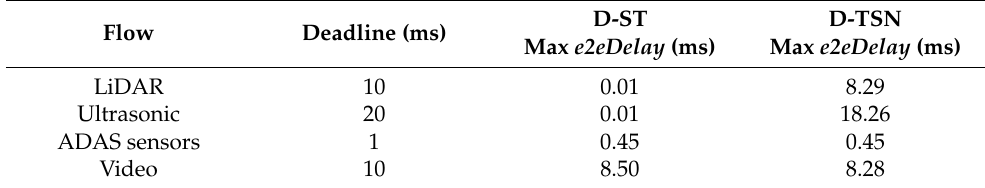
Table 5. Simulation results: maximum end-to-end delay.